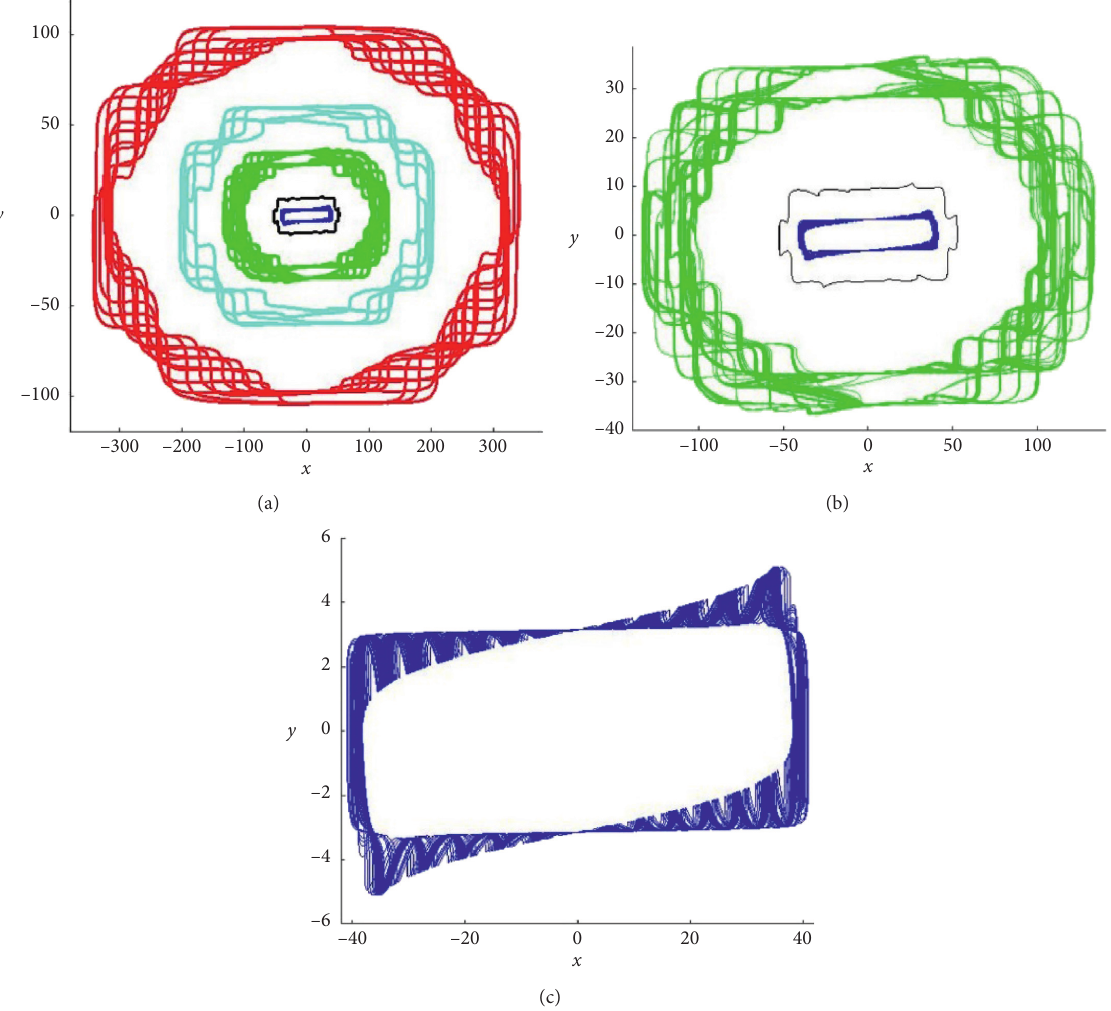
Figure 5: Trajectories when A and w are 2 and 0 . 5, respectively. (a) The set initial values are ( 0 , 2 ) , ( 0 , 8 ) , ( 0 , 30 ) , ( 0 , 80 ) , and ( 0 , 100 ) . (b and c) are zoomed versions of (a) for a better